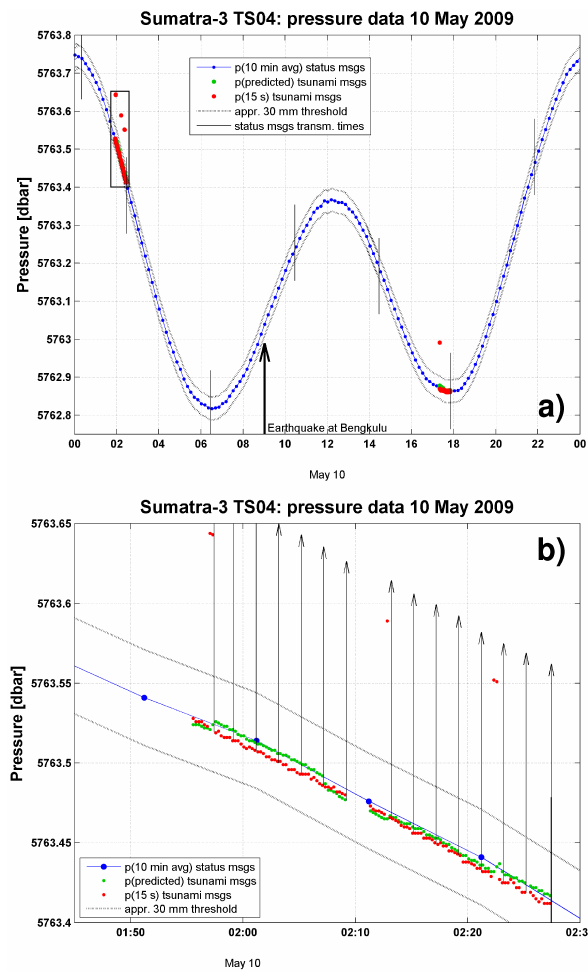
Fig. 16. (a) Bottom pressure data from position Sumatra-3 on 10 May 2009. Red dots indicate in-situ pressure data during two false tsunami alarms (triggered by spikes in the pressure record). The time of Bengkulu earthquake is marked by a bold arrow. Vertical lines indicate the timing of status message transmissions. (b) Zoom- in of the first (false) tsunami alarm. Arrows indicate the timing of alarm messages. Note the 2 consecutive false measurements at about 01:58, triggering the transmission of the first alarm message immediately after. Later outliers do not re-trigger the tsunami mode. At 02:10, a single alarm message (containing 8 data points from the last 2min) is missing. The first tsunami message contains 6 normal values followed by the first two outliers. The predicted pressure values (green dots), however, increase by 5mm after the 7th data point, when the last 10 min average polynomial node starts to be affected by the